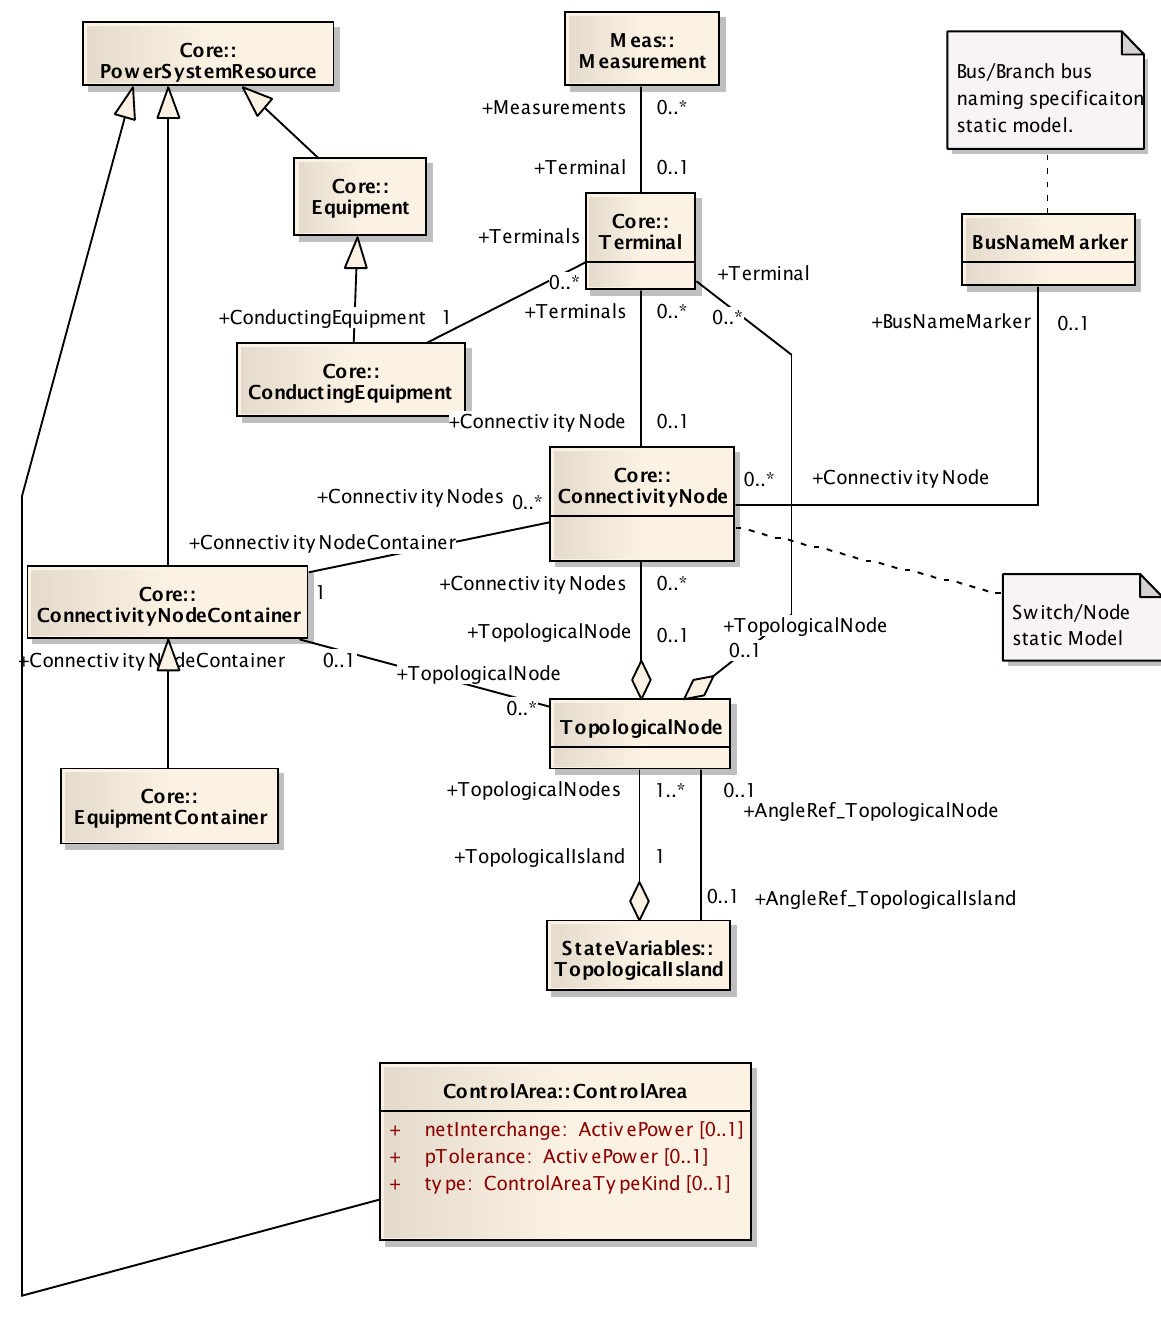
Figure 5. UML diagram of the CIM ontology part dealing with the connection of power system